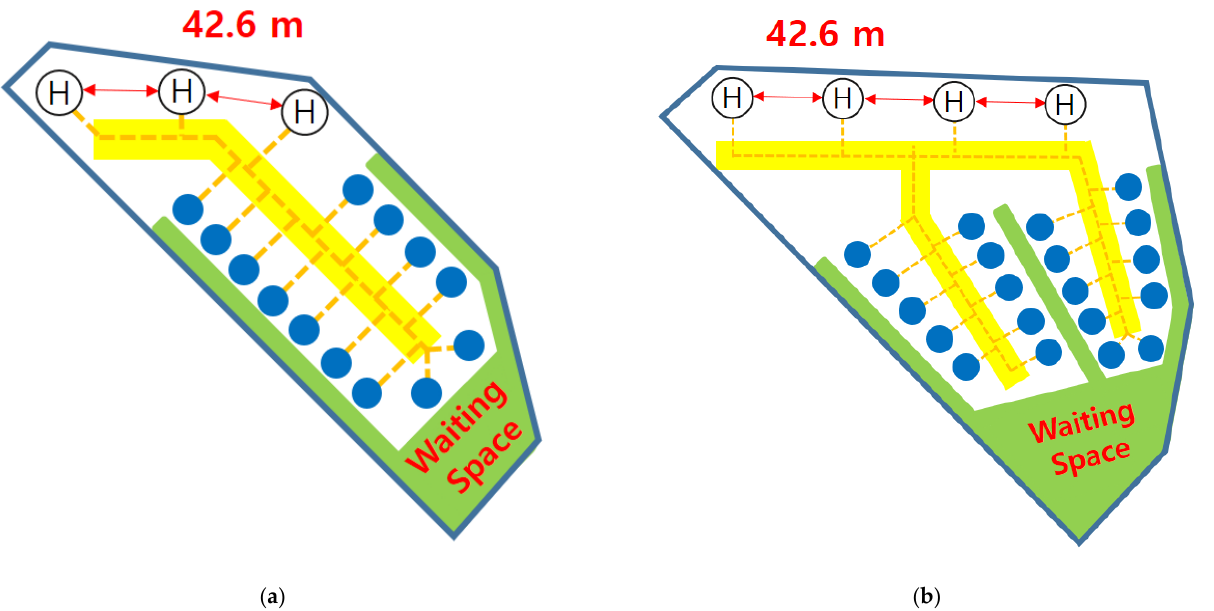
Figure 22. Pier topologies for the Gimpo Airport parking lot that comply with the EASA’s new regulations: ( a ) current parking space; ( b ) expanded parking space.